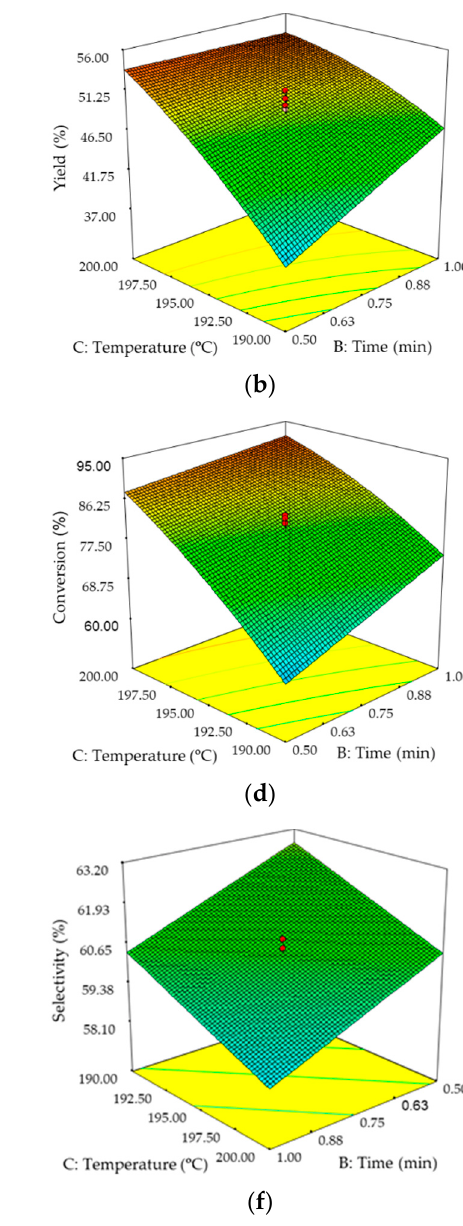
Figure 3. Response surfaces obtained for the composite central design: ( a ) influence of FeCl 3 concentration and temperature on yield; ( b ) influence of time and temperature on yield; ( c ) influence of FeCl 3 concentration and temperature on conversion; ( d ) influence of time and temperature on conversion; ( e ) influence of FeCl 3 concentration and temperature on selectivity; ( f ) influence of time and temperature on selectivity.